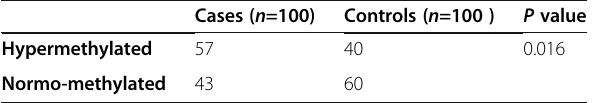
Table 3 Number of hypermethylated and normo-methylated RPL cases vs. number of hypermethylated and normo- methylated controls